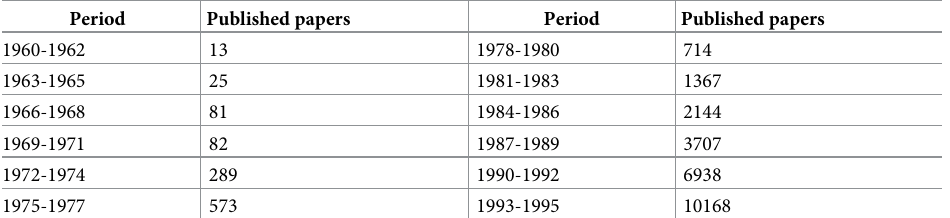
Table 3. Papers published in 3-year time interval.